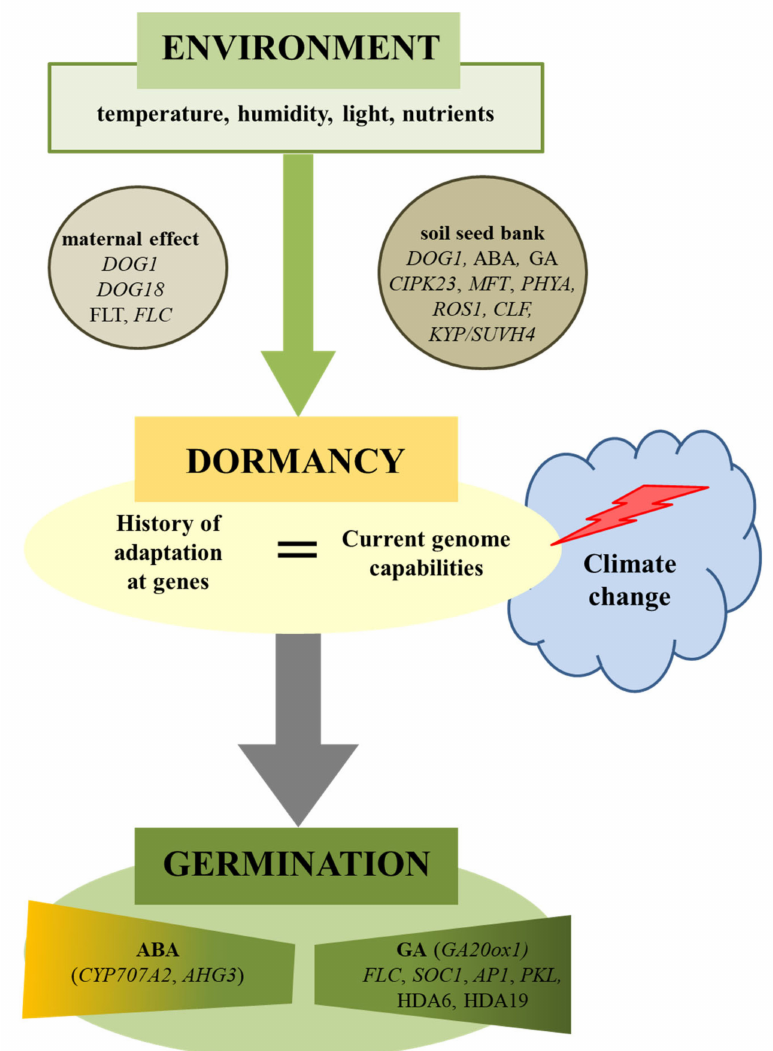
Figure 1. Environmental regulation of plant seed dormancy and germination. Seed germination is dependent on environmental conditions acting during maturation (maternal effect) as well as during storage (soil seed bank). Climate change can cause disturbances in the seed germination if the history of species (genetics) as well as the present (ecology) will not match. Physiological and molecular factors were involved in this regulation. ABA-hypersensitive Germination 3 (AHG3), abscisic Acid ( ABA ), Apetala1 ( AP1 ), Cbl-Interacting Protein Kinase 23 ( CIPK23 ), Curly Leaf ( CLF ), Cytochrome P450 Monooxygenase ( CYP707A2 ), Delay OF Germination 1 ( DOG1 ), Flowering Locus T ( FLT ), Flowering Locus C ( FLC ), Giberellic Acid ( GA ), Gibberellin 20-Oxidase 1 ( GA20ox1 ), Histone Deacetylase 6 ( HDA6 ), Kryptonite ( KYP/SUVH4 ), Mother OF Flowering Time ( MFT ), Nitrite Reduc- tase 1 ( NRT1.1 ), Pickle ( PKL ), Phytochrome A ( PHYA ), Repressor OF Silencing1 ( ROS1 ), Suppressor of Overexpression of Constans 1 ( SOC1